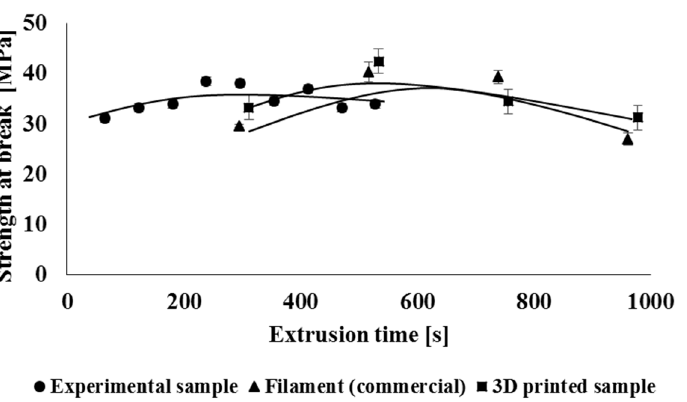
Figure 17. Dependence of the elongation at break on the total processing time of the polymeric material. 4.6. Flexural Test Flexural strength provides information about the material’s ability to withstand deformation under stress. The flexural test was investigated on the filaments prepared in the process of industrial recycling. Figure 18 shows a slight decrease in the maximum flexural strength values of the individual samples due to multiple processing (recycling) of the tested polymeric material. The decrease in flexural strength values of the tested samples is caused by partial degradation during processing, when the molar mass of the polymer blend decreases, but the decrease in maximum flexural strength even after nine processing cycles of the polymer blend shows only 7% of the value as compared with the original non-recycled sample. In addition, only minimal changes during multiple processing occurred in the case of deformation at the flexural strength (Figure 19) and also in the evaluation of Young’s modulus (Figure 20), when the values of the investigated parameters were in the range of statistical measurement errors even after multiple processing as compared with non-recycled material.